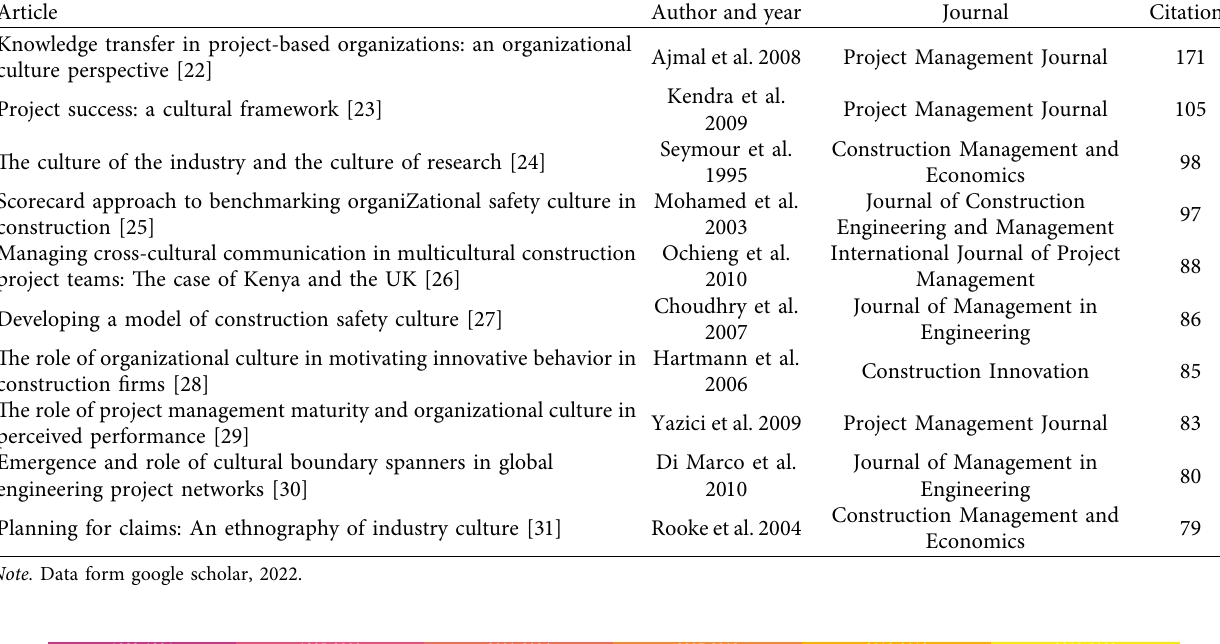
Table 1: The top 10 cited articles of culture in construction in 1989–2022.